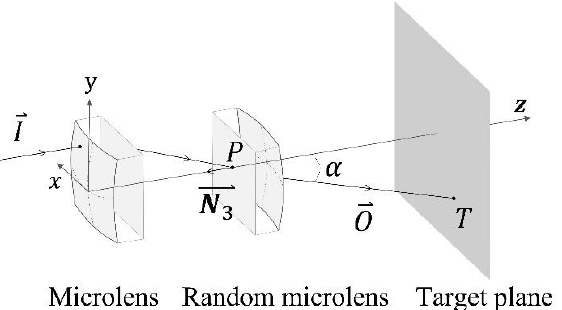
Figure 4. The design schematic diagram of the double-layer microlens array.